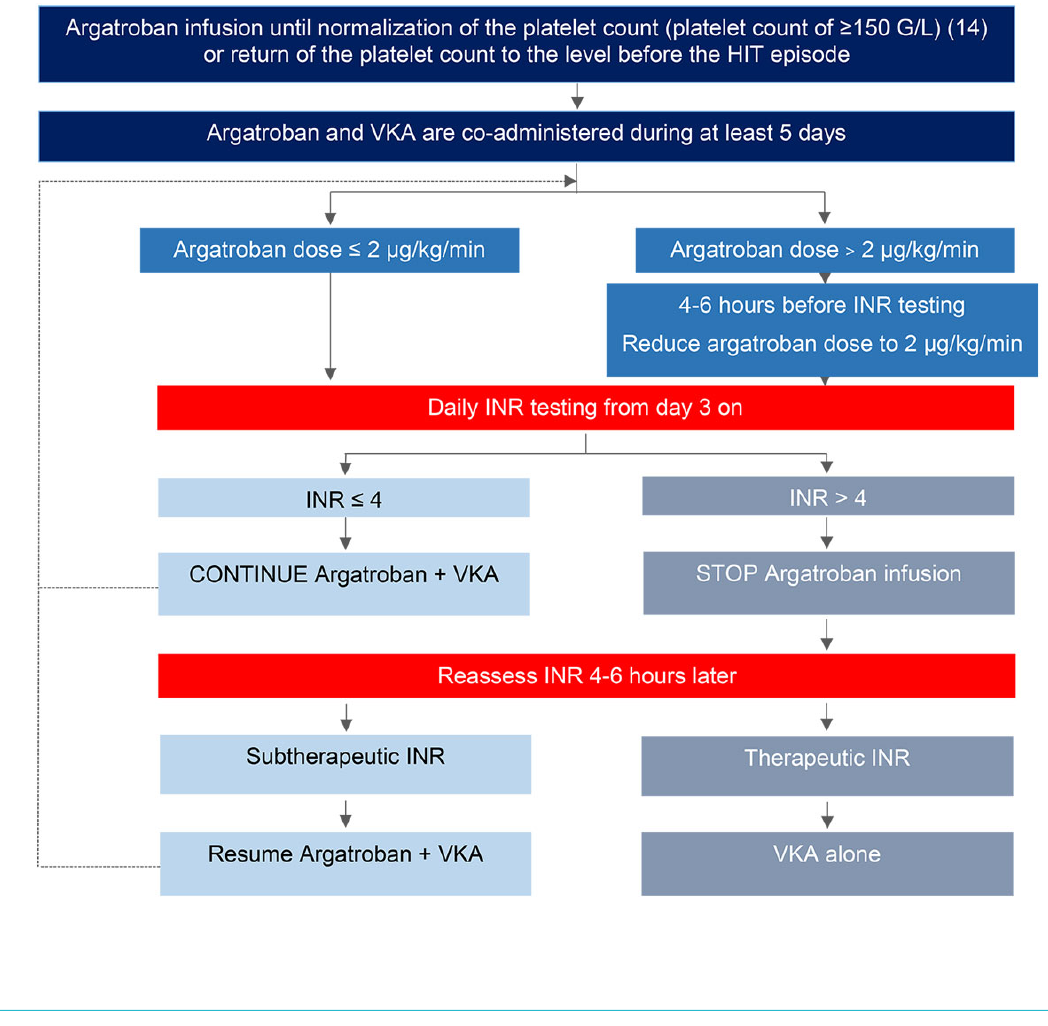
Figure 1: Proposed algorithm for transitioning patients from argatroban to vitamin K antagonists (VKA) [15, 41,